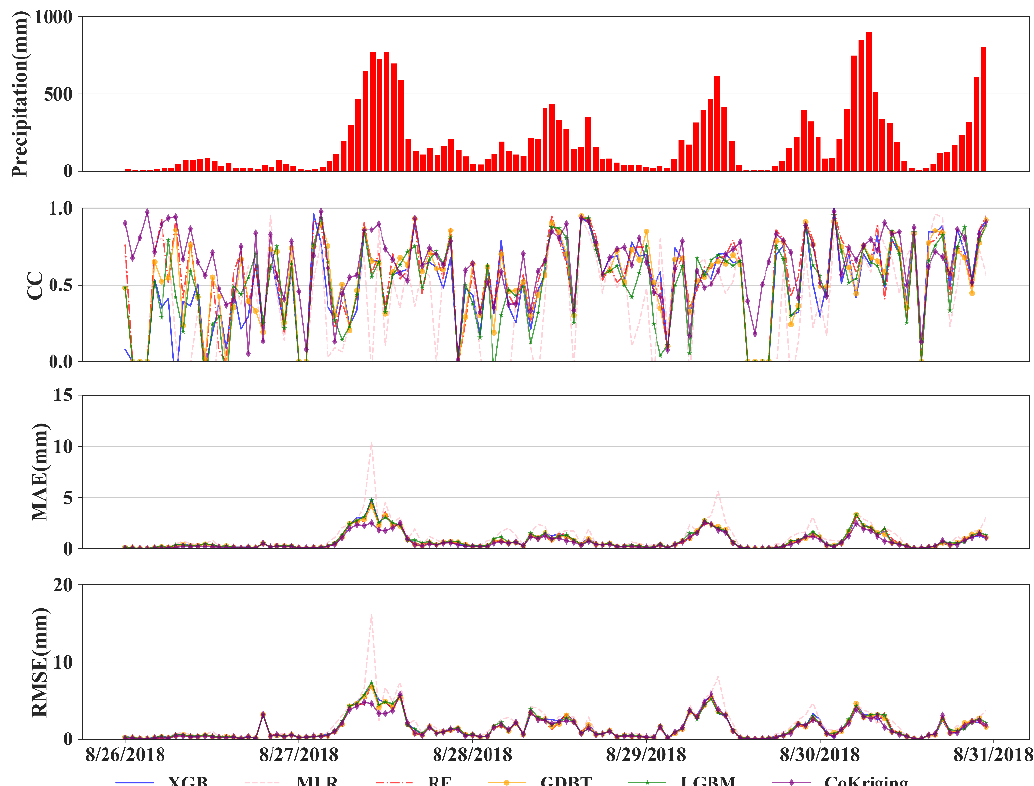
Figure 10. Evaluation indices of heavy rainfall event III.